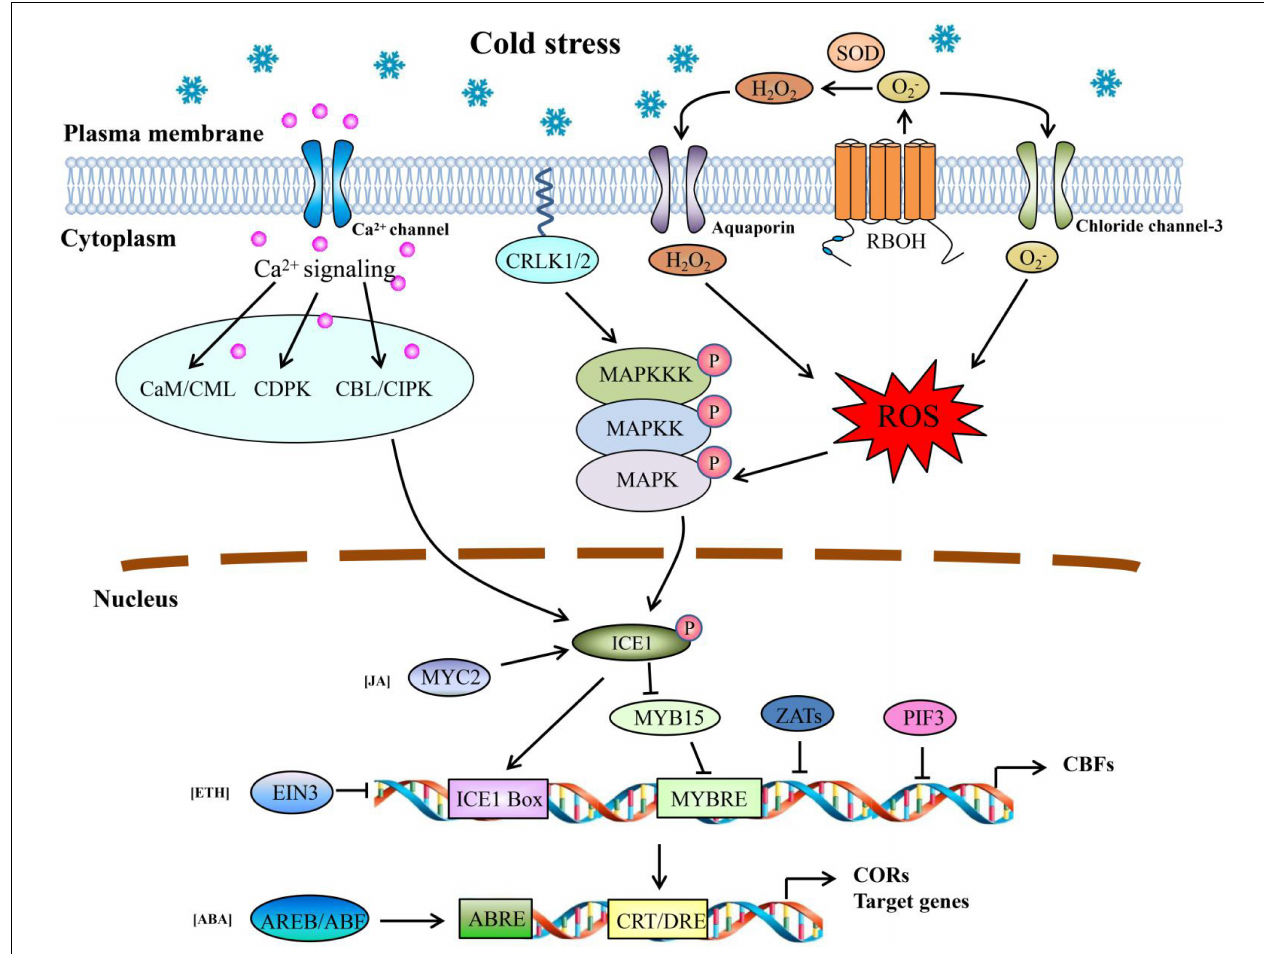
FIGURE 8 | Model of the multiple signal transduction pathways and transcriptional networks during cold stress in pepper. Arrows represent positive regulation, whereas lines ending with a bar represent negative